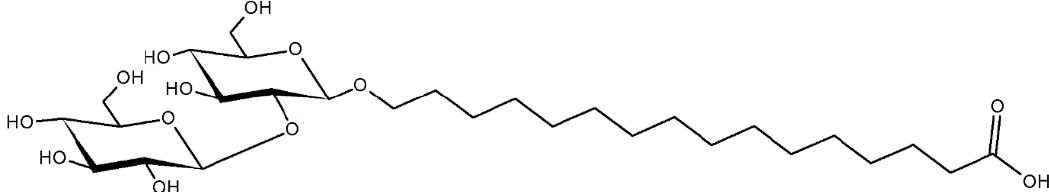
Figure 8. Molecular structure of the novel C16:0 sophorolipids after alkaline hydrolysis.